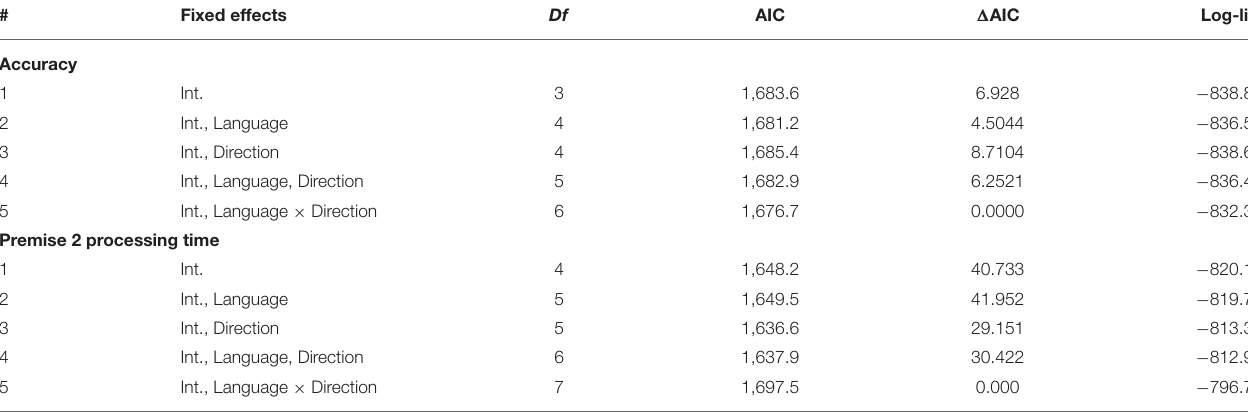
TABLE 5 | Models testing sequence for Accuracy and Premise 2 processing time.